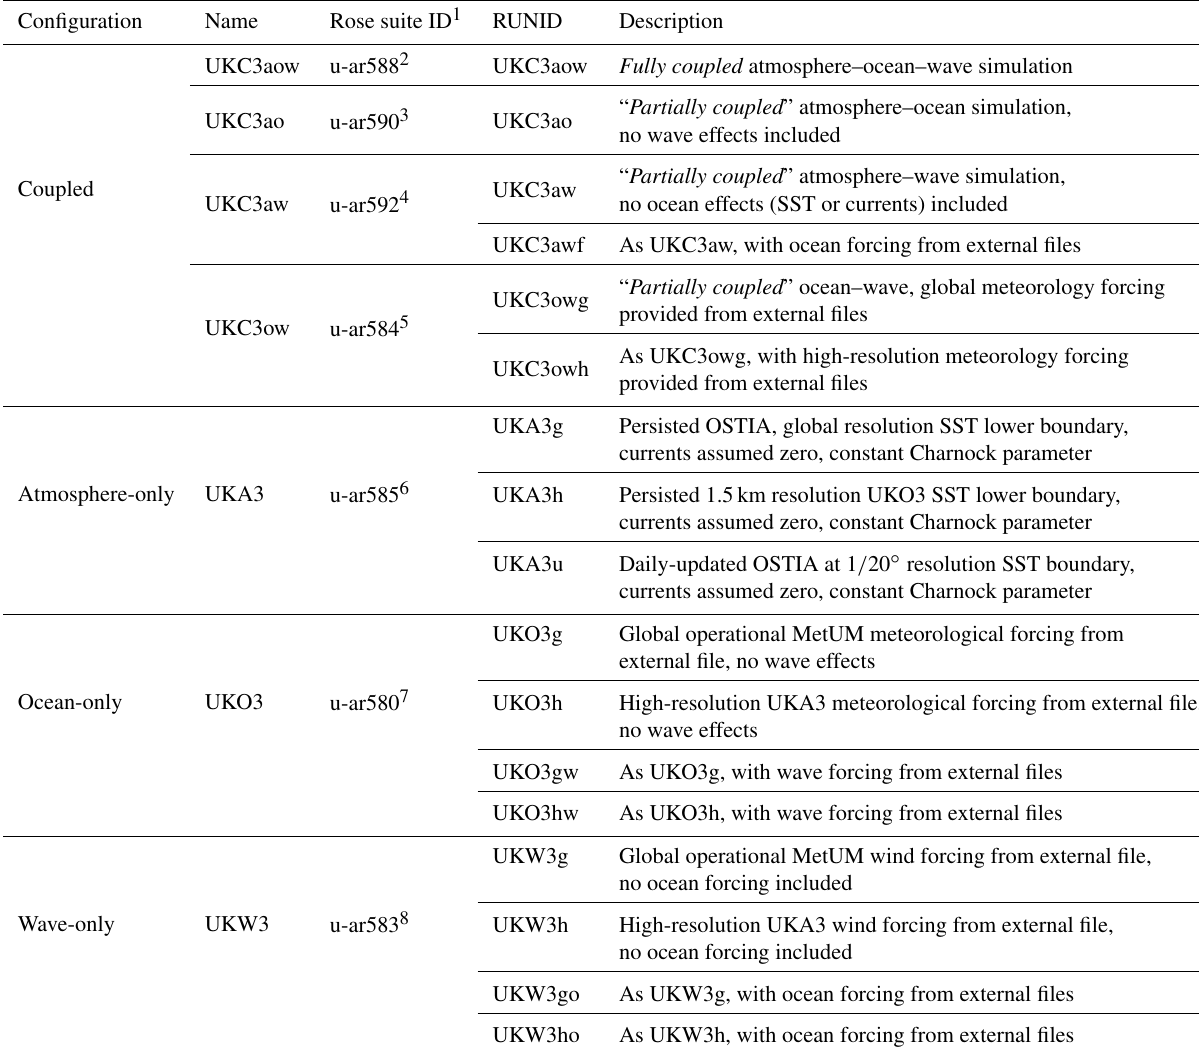
Table 2. Summary of UKC3 system coupled and uncoupled evaluation suites.